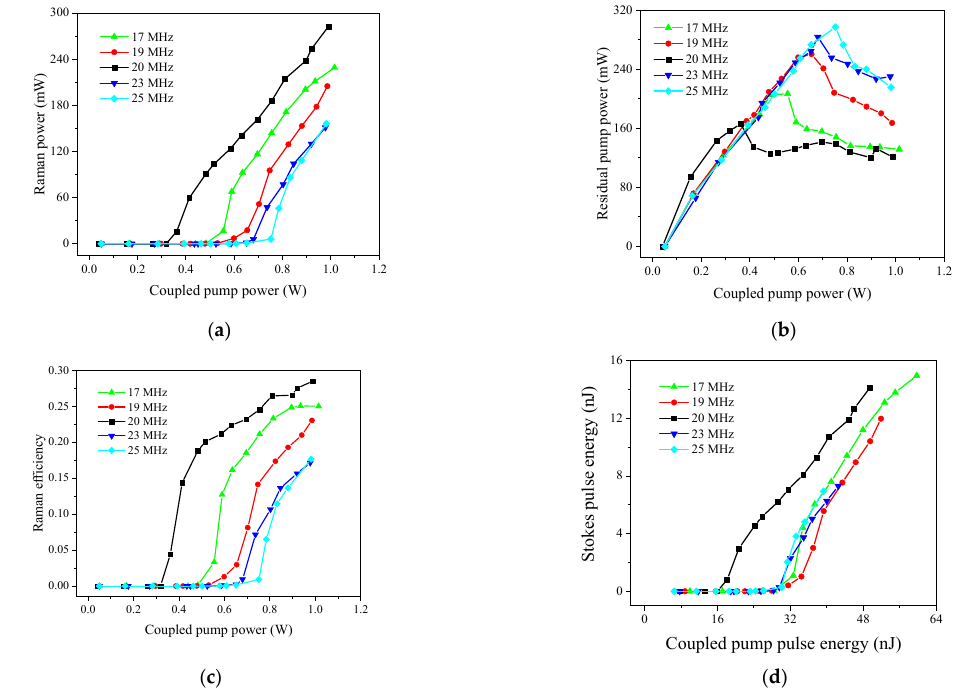
Figure 8. The output power characteristics of the FGRL with different repetition frequencies (pulse width 4 ns). ( a – c ) The Raman power, residual pump power and Raman efficiency, respectively. ( d ) The Stokes pulse energy with coupled pump pulse energy in different repetition frequency.